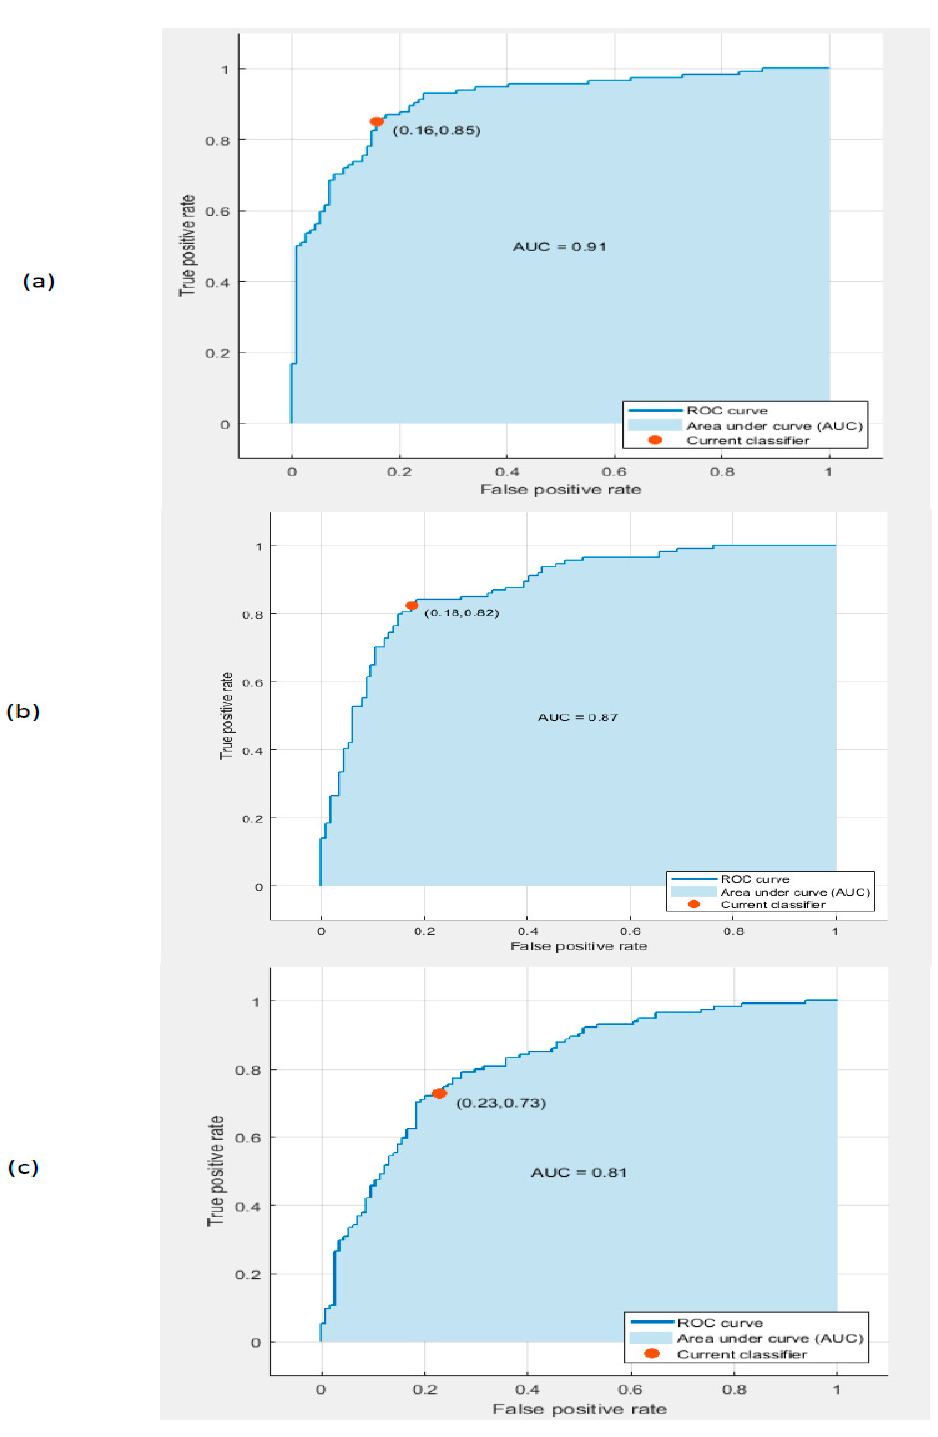
Figure 7. The receiver operating characteristic (ROC) curves for the linear SVM classifier trained with deep features extracted from the ( a ) GoogleNet DCNN, ( b ) AlexNet DCNN, and ( c ) ResNet 50 DCNN after PCA.